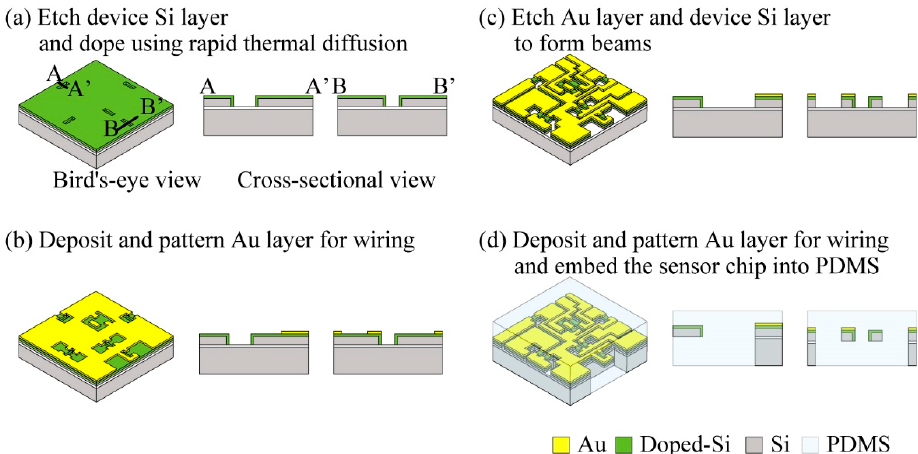
Figure 7. Overview of the fabrication process of the sensor. ( a ) step to fabricate piezoresistor on multiple walls, ( b ) step to form metal wiring, ( c ) Step to release sensing elements, ( d ) step to embed sensor chip inside silicone rubber (PDMS).